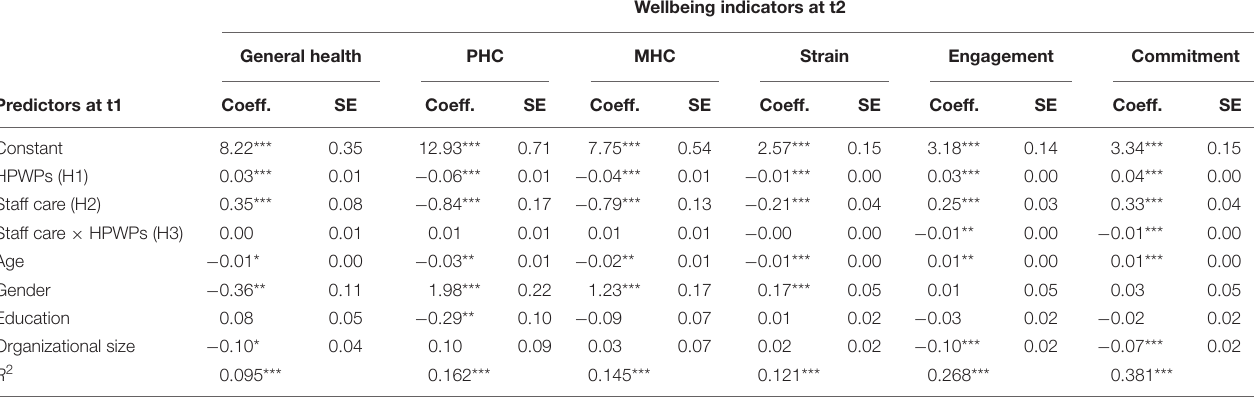
TABLE 2 | Moderation analyses to predict